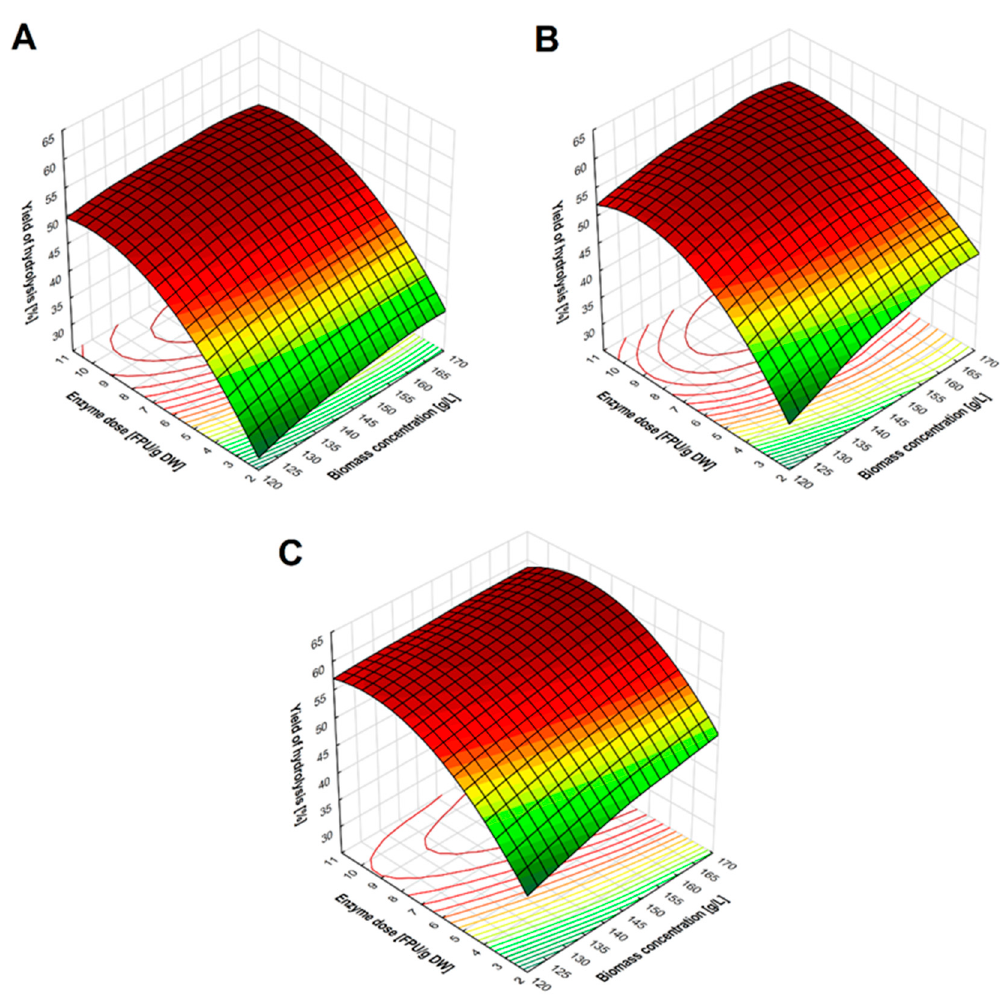
Figure 3. Graph showing the effect of biomass concentration and enzyme dose on the yield of cellulose enzymatic hydrolysis after 24 ( A ), 48 ( B ) and 72 ( C ) hours. The highest efficiency of cellulose enzymatic hydrolysis, ca. 60%, was achieved after 72 h of the process, for a biomass concentration of 143 and 167 g/L and a dose of cellulolytic enzyme preparation of 10 FPU/g of biomass. When the enzyme preparation was used at a dose of 5 FPU/g of biomass, the hydrolysis efficiency only decreased by about 3% under identical process conditions (Figure 3). Using the lowest dose of cellulase complex (2.5 FPU/g of biomass) significantly decreased the hydrolysis efficiency by ca. 10–16% compared to the effectiveness obtained for higher doses of the preparation. Importantly, at this stage of the research, a slightly negative impact of higher biomass concentrations (after pretreatment with microwaves 40% w / v NaCS) on hydrolysis efficiency was observed. Despite the lower water activity in the solutions containing an increased biomass concentration (143 and 167 g/L), an increase in the hydrolysis efficiency (1–5%) was ob- served compared to the solutions containing 125 g of biomass per liter (Figure 3). The analysis of variance (ANOVA) showed a statistically significant influence of linear terms (biomass concentration, enzyme dose and hydrolysis time) on the effectiveness of the cel- lulose degradation process, with p < 0.05 (Table Supplementary Material). The correlation between enzyme dose and hydrolysis time was also determined at p < 0.05. The conducted analyses did not show any influence of the variable pairs: enzyme dose/biomass concen- tration and biomass concentration/hydrolysis time on the process efficiency. This showed that the biomass prepared with the use of a hydrotrope and microwaves could be very